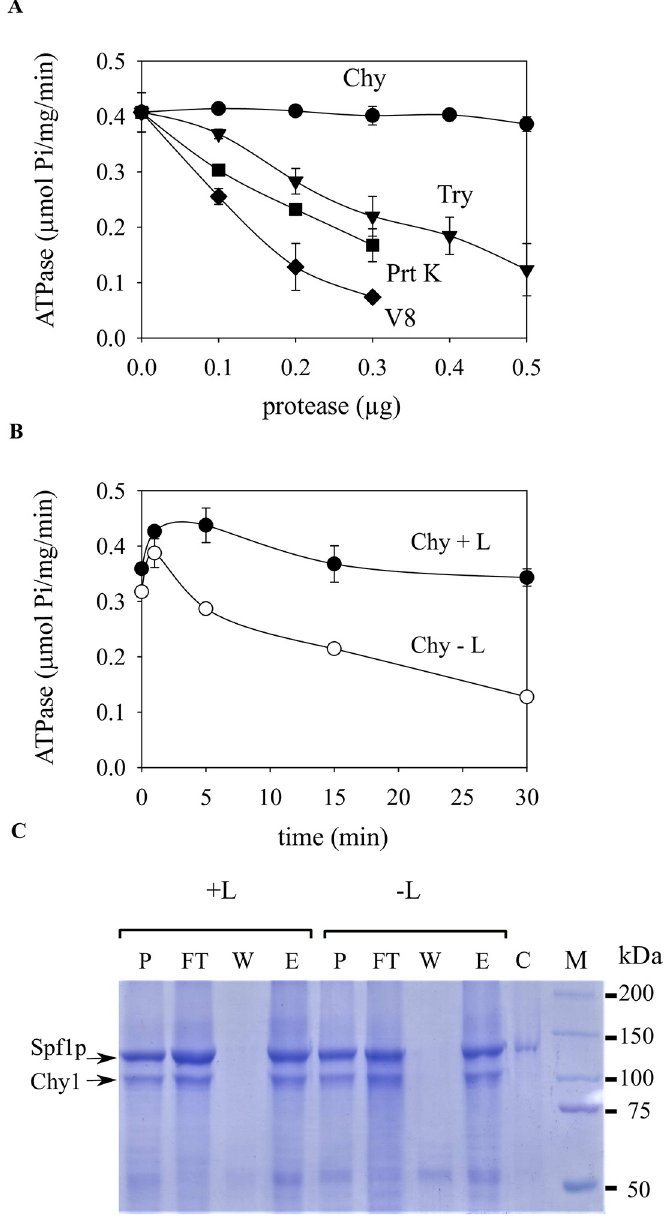
Fig 6. A. Effect of limited proteolysis on the ATPase activity of Spf1p. 4 μ g of Spf1p from detergent-lipid micelles was digested for 30 min at 28˚C with different amounts of the protease indicated in the figure. The chymotrypsin and trypsin digestions were stopped by the addition of 20 μ g aprotinin, and proteinase K and V8 digestions were stopped by the addition of 0.5 mM PMSF. The ATPase activity was measured as described under “Materials and methods”. B. 10 μ g of Spf1p in detergent micelles was exposed to chymotrypsin for different times, either in the absence (-L ) or in the presence (+L) of PC. The proteolysis was ended by the addition of aprotinin and after the addition of PC to (-L) samples, the ATPase activity was measured. C. The Chy1 fragment does not dissociates from the micelle after proteolysis. 20 μ g of Spf1p in detergent micelles was exposed to chymotrypsin for 5 min, either in the absence (-L ) or in the presence (+L) of PC. After stopping the reaction an aliquot of the proteolyzed sample was saved (P), and the rest was incubated with 50 μ l of Ni-NTA agarose, washed three times with 1 ml of solution containing 0, 25 and 50 mM imidazole and finally eluted with 1 ml of 500 mM imidazole. The protein from 100 μ l of each step was precipitated with TCA, separated by SDS-PAGE and stained with Coomasie blue. P , proteolyzed sample before incubation with Ni-NTA resin, FT , supernatant containing part of the sample that did not bound to the Ni-NTA resin after the incubation, W , final wash with 50 mM imidazole, E , eluate of 500 mM imidazole. C , control of undigested Spf1p (0.75 μ g), M , molecular weight